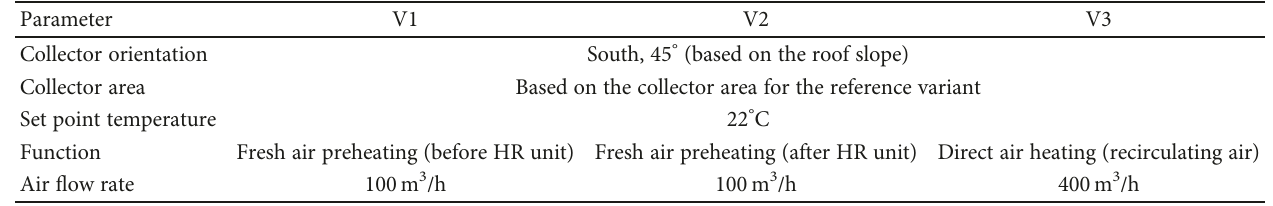
Table 5: Air heating mode (V1, V2, and V3).